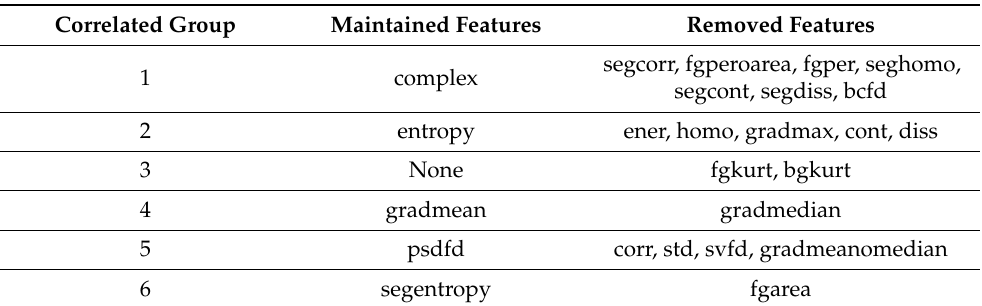
Table 2. Correlated feature groups and selection performed. Both foreground (fgkurt) and back- ground (bgkurt) kurtoses were removed, as they were always close to each other and showed no significant distinction among various image phenomena.